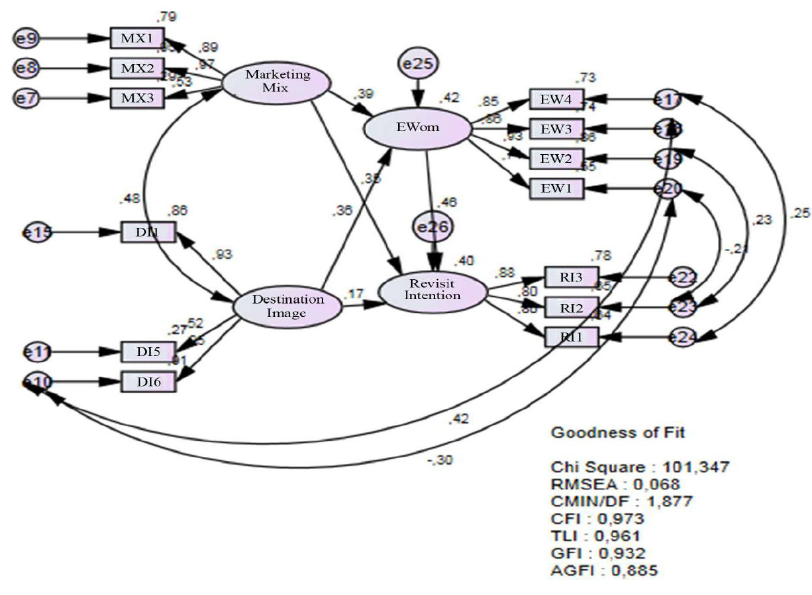
Fig. 3. CFA results fitting the model